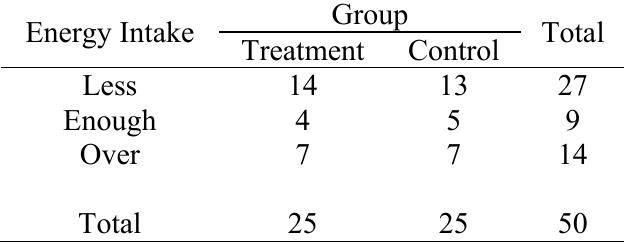
Table 3. Characteristic of samples based on